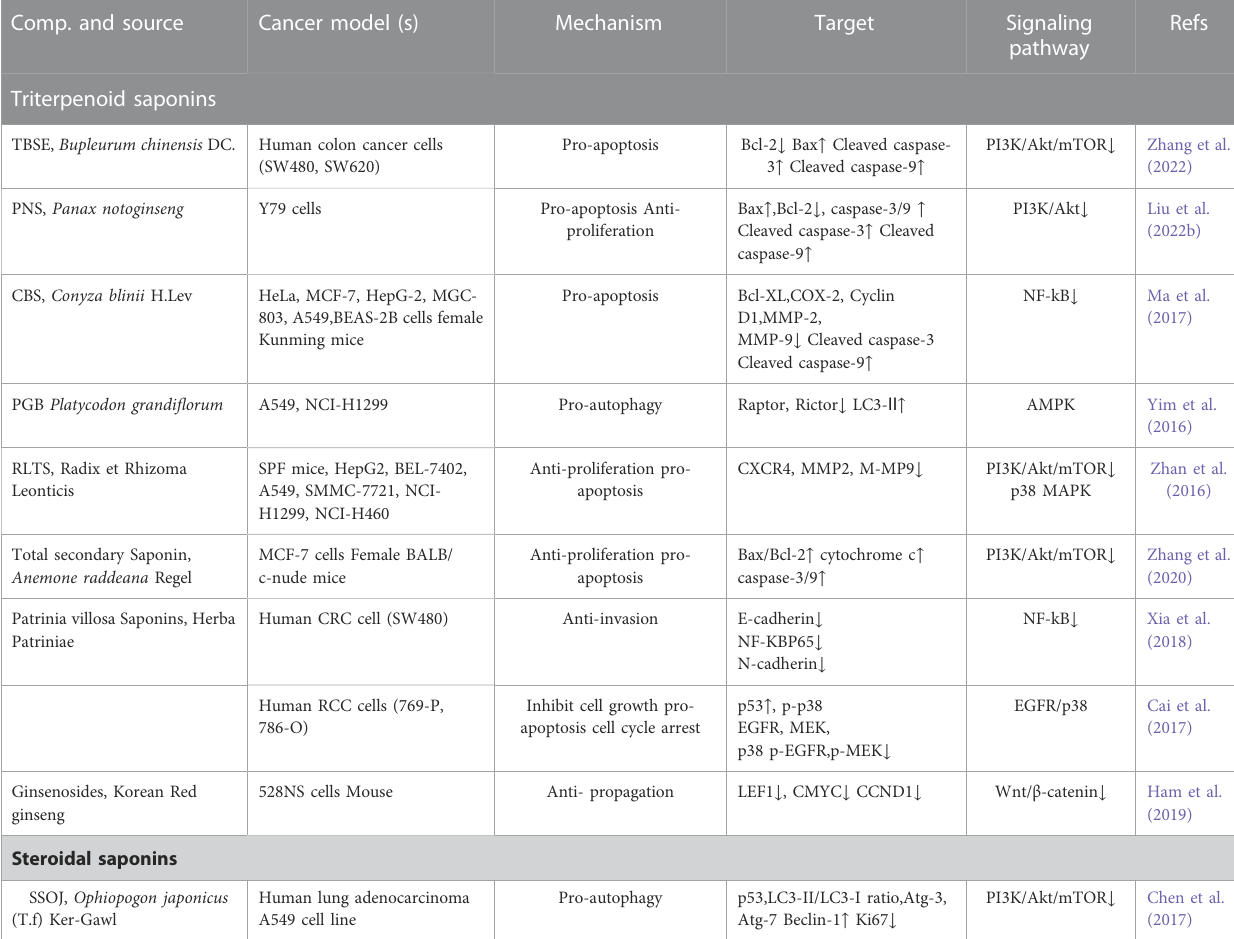
TABLE 2 Total saponin extracts against cancer. Up arrows indicate upregulation, while the down arrows indicate downregulation. Comp. and